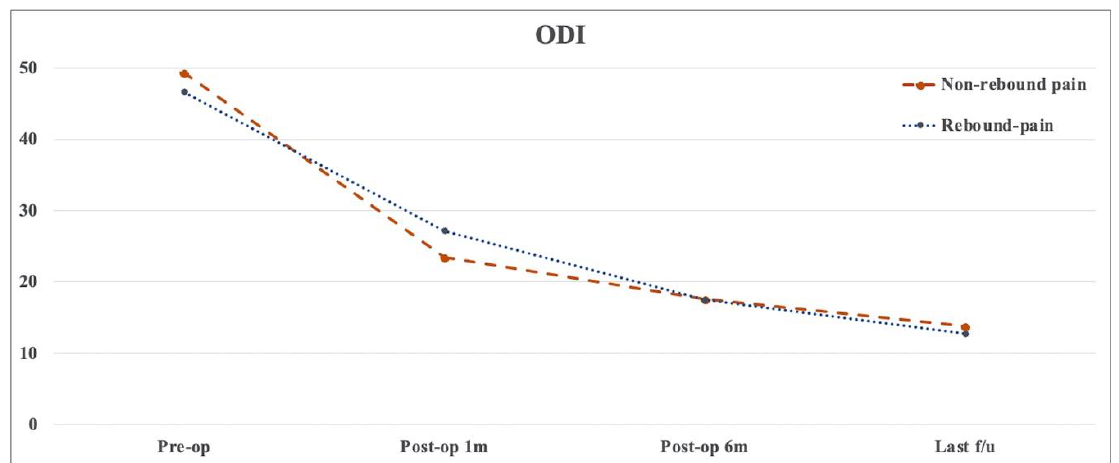
Figure 3. Changes in visual analog scale scores with time in the rebound pain group.